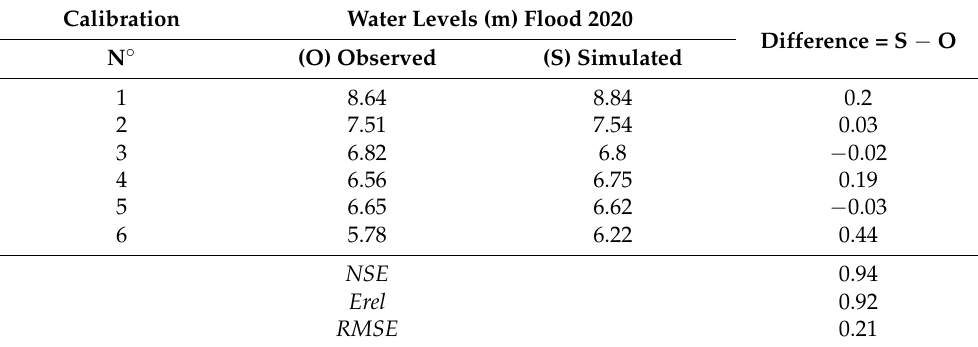
Table 2. Comparison of the water levels (meters) between those observed and simulated by